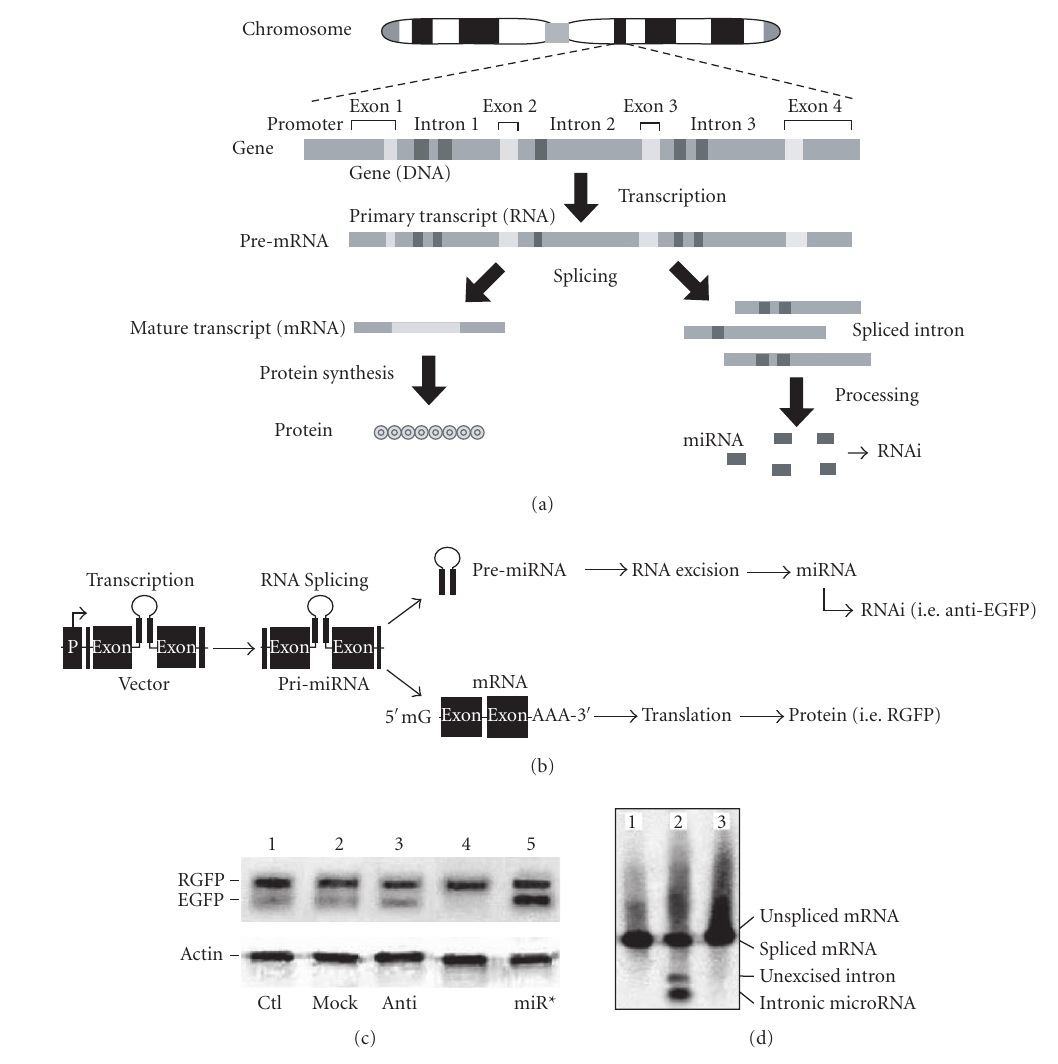
Figure 2: Biogenesis and function of intronic miRNA. (a) The native intronic miRNA is cotranscribed with a precursor messenger RNA (pre- mRNA) by Pol-II and cleaved out of the pre-mRNA by an RNA splicing machinery, the spliceosome. The spliced intron with hairpin-like secondary structure is further processed into mature miRNA capable of triggering RNAi e ff ects, while the ligated exons become a mature messenger RNA (mRNA) for protein synthesis. (b) We designed an artificial intron containing pre-miRNA, namely SpRNAi, mimicking the biogenesis of the native intronic miRNA. (c) When a designed miR-EGFP(280–302)-stemloop RNA construct was tested in the EGFP- expressing Tg(UAS:gfp) zebrafish, we detected a strong RNAi e ff ect only on the target EGFP (lane 4). No detectable gene-silencing e ff ect was observed in other lanes; from left to right: 1, blank vector control (Ctl); 2, miRNA-stemloop targeting HIV-p24 (mock); 3, miRNA without stemloop (anti); and 5, stemloop-miRNA ∗ complementary to the miR-EGFP(280–302) sequence (miR ∗ ). The o ff -target genes, such as vector RGFP and fish actin, were not a ff ected, indicating the high target specificity of miRNA-mediated gene silencing. (c) Three di ff erent miR-EGFP(280–302) expression systems were tested for miRNA biogenesis; from left to right: 1, vector expressing intron-free RGFP, no pre- miRNA insert; 2, vector expressing RGFP with an intronic 5 (cid:2) -miRNA-stemloop-miRNA ∗ -3 (cid:2) insert; and 3, vector similar to the 2 construct but with a defected 5 (cid:2) -splice site in the intron. In Northern blot analysis probing the miR-EGFP(280–302) sequence, the mature miRNA was released only from the spliced intron resulting from the vector 2 construct in the cell